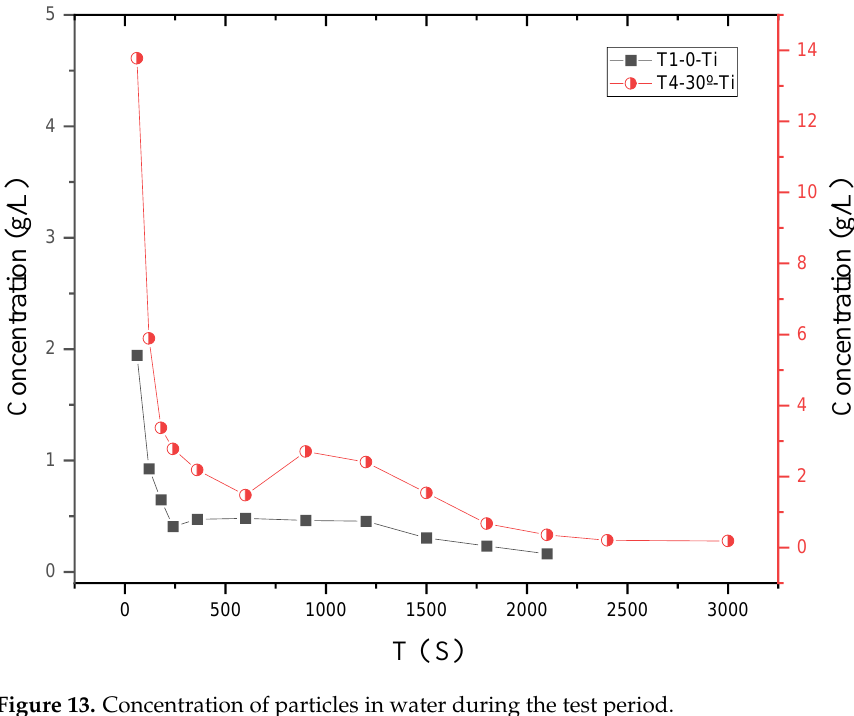
Figure 13. Concentration of particles in water during the test period.